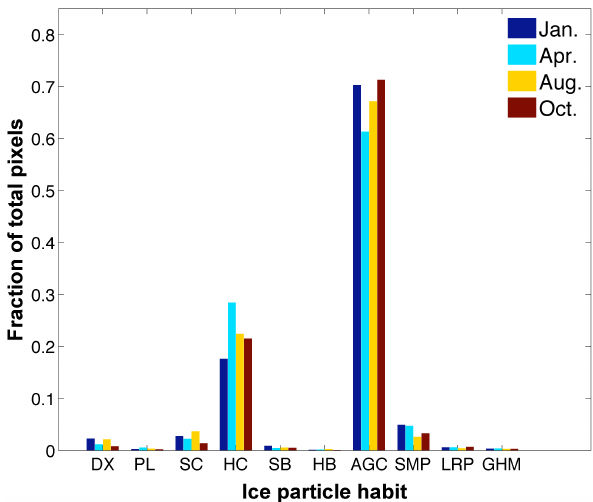
Fig. 2. Ice habit inferred in tropical regions for data from four dif- ferent months, shown as a histogram of the fraction of total pixels assigned as one of the 9 single habits or general habit mixture de- fined in Fig.